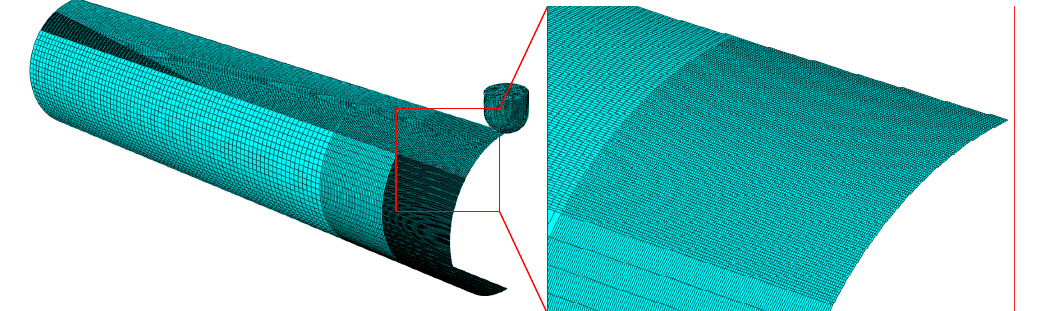
Figure 4. Mesh generation of the dented pipe model.